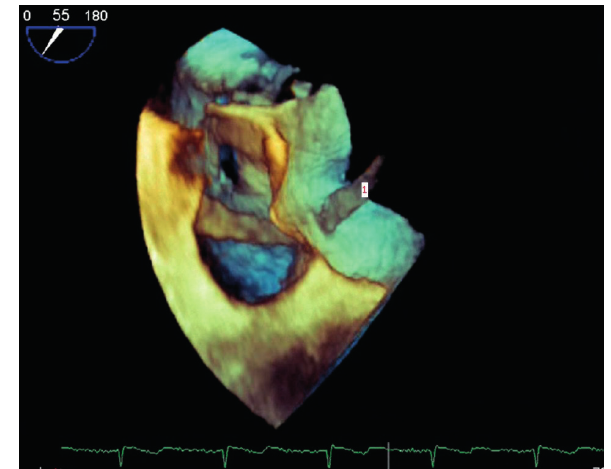
Fig. 2. 3D-ECHO image showing a thrombus captured in the interatrial septum (indicated by No